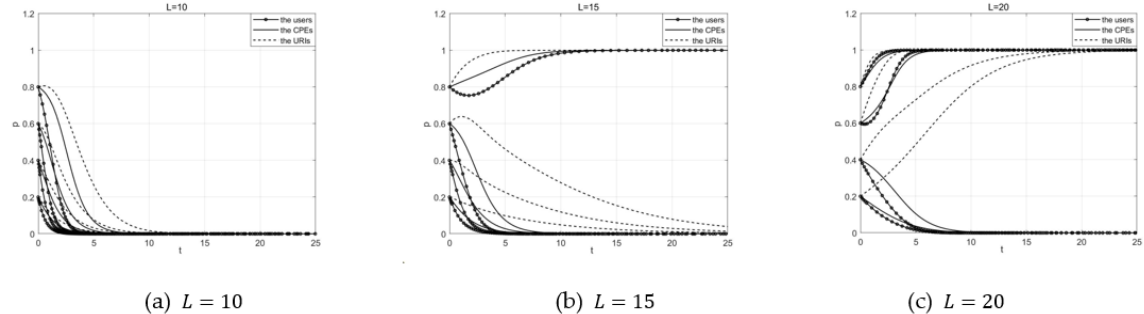
Figure 4. Impact of risk perceived loss on the strategies of the Users, the CPEs and the URIs, and ( a – c ) show the evolution of the tripartite strategies under different values of L .